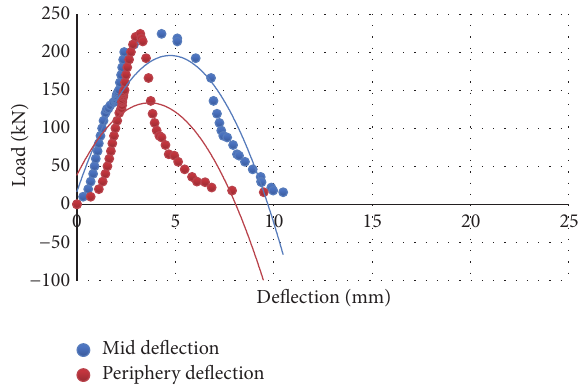
Figure 7: Punching shear values for 0.5% of steel fibre